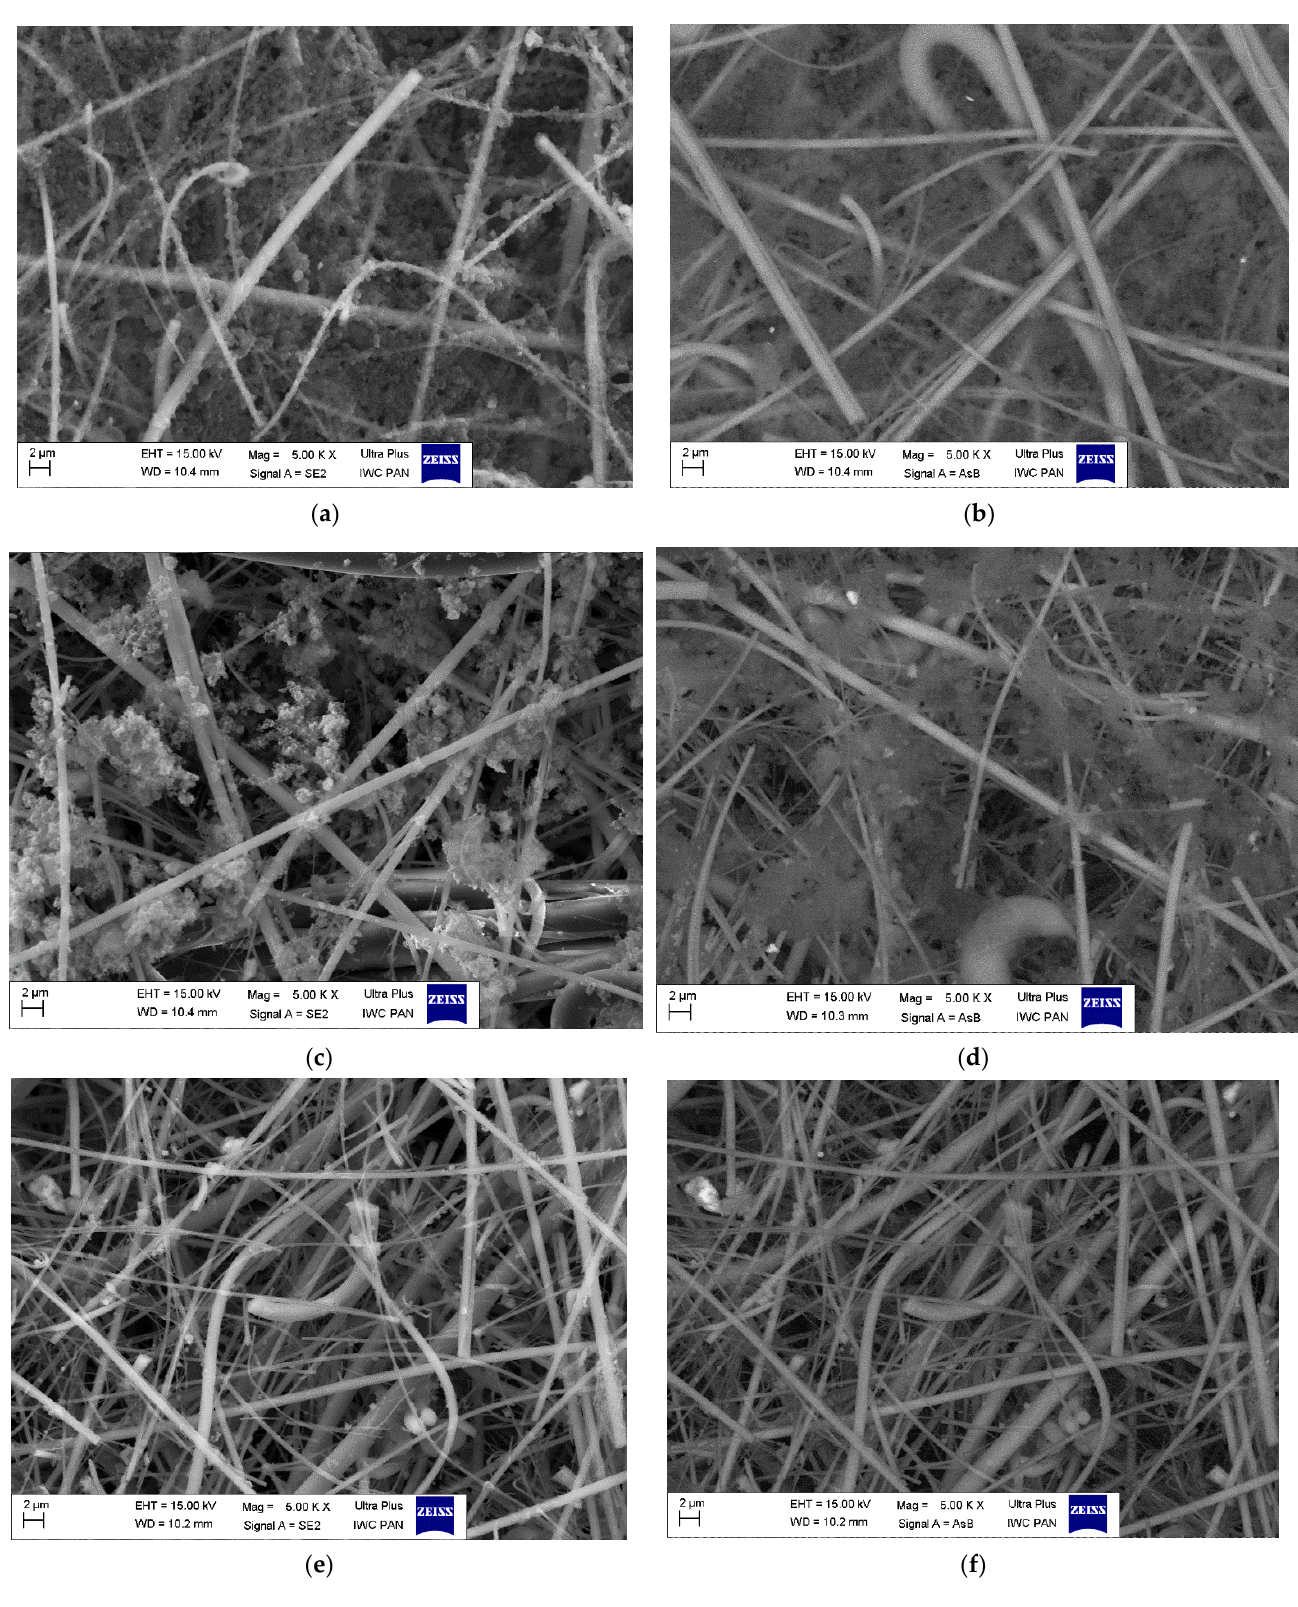
Figure 11. SEM images for Diesel engine in SE2 mode ( a ), and AsB mode ( b ); petrol engine (scooter) in SE2 mode ( c ), and AsB mode ( d ); pure filter in SE2 mode ( e ) and AsB mode ( f ).